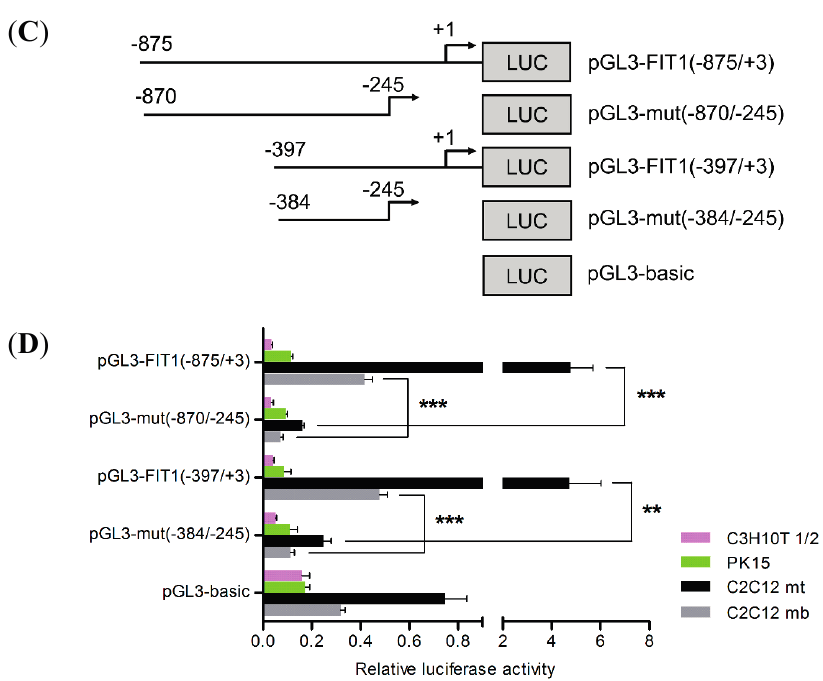
Figure 2. Promoter activities of porcine FIT1 gene are activated by the conserved E-boxes in C2C12 myotubes. ( A ) Schematic structures of various progressive deletions in the 5 ′ -flanking region of the porcine FIT1 gene; ( B ) activities of the deletion fragments of the porcine FIT1 promoter in myogenic and non-myogenic cells. Data are shown as the means ± SD ( n = 4). ** p < 0.01; *** p < 0.001 by ANOVA. Purple bar denotes C3H10T 1/2 cells; green bar denotes porcine PK15 cells; black bar denotes C2C12 myotubes (mt); gray bar denotes C2C12 myoblasts (mb); ( C ) the graphic indication of the new mutated deletions of the conserved E-boxes from the promoter region; ( D ) activities of the new mutated fragments in myogenic and non-myogenic cells. The fragments of pGL3-FIT1( − 875/+3) and pGL3-FIT1( − 397/+3) were used as positive control. Data are shown as the means ± SD ( n = 3). ** p < 0.01; *** p < 0.001 relative to the positive control (2-tailed student’s t -test). Purple bar denotes C3H10T 1/2 cells; green bar denotes porcine PK15 cells; black bar denotes C2C12 myotubes (mt); gray bar denotes C2C12 myoblasts